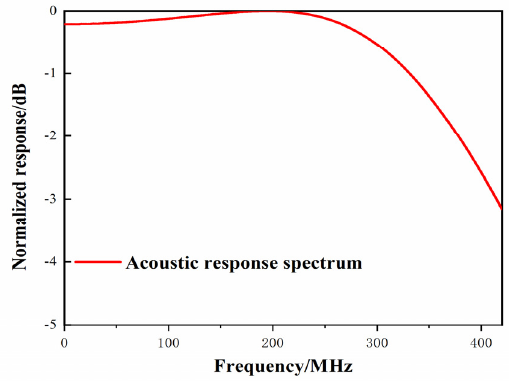
Figure 6. The frequency response of an acoustic sensor based on a slotted waveguide.